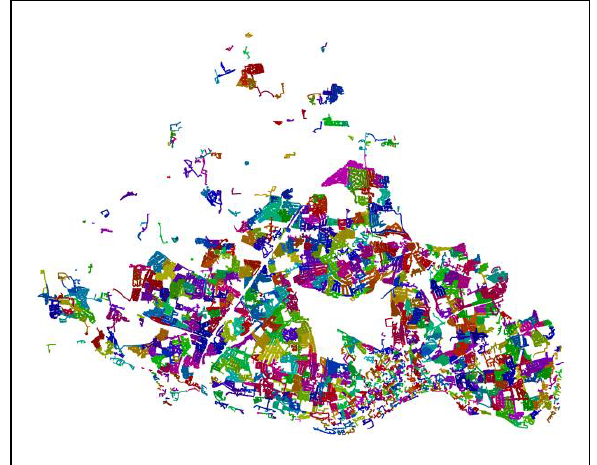
Figure 10. Synthetic electricity distribution networks generated for Newcastle upon Tyne. Each colour refers to a network instance (Contains OS data © Crown copyright and database right